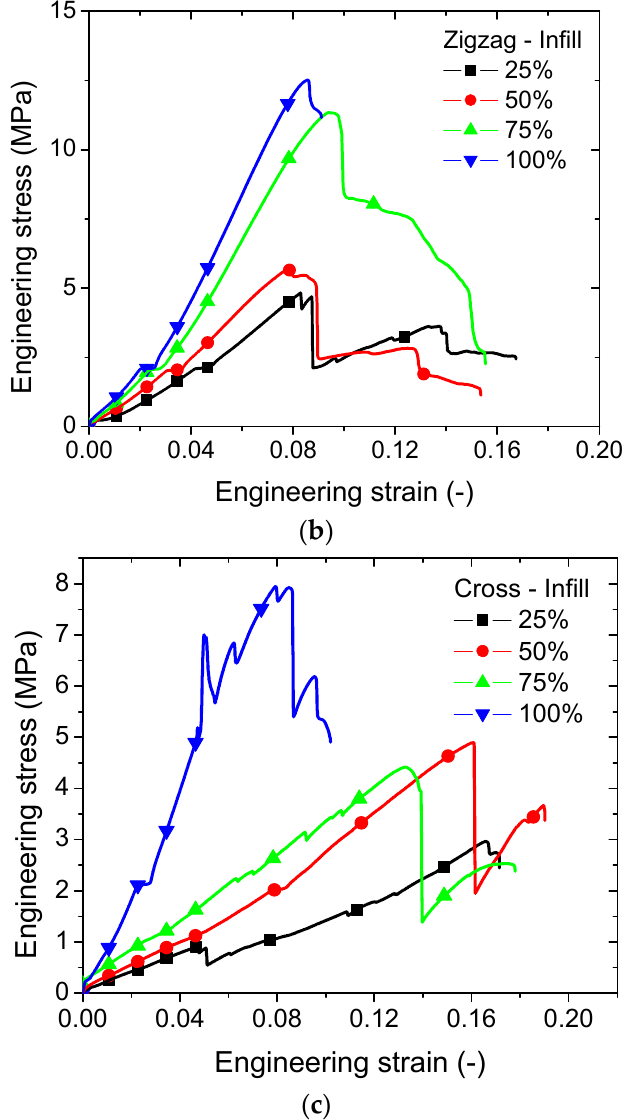
Figure 4. Tensile response as a function of infill and pattern type. ( a ) zigzag, ( b ) gyroid, ( c ) cross. The correlation between the engineering constants (Young’s modulus, tensile strength, elongation at break) and the infill ratio can be captured from Table 1. The increase of the infill ratio has a direct consequence on the improvement of stiffness and strength and the decrease of elongation at break of the printed PLA–carbon fibres. The ranking of all engineering constants with regards to the type of the pattern is also evidenced. This ranking from the best performing to the lowest is as follows: gyroid, zigzag, cross. According to the data reported in Table 1, the trend exhibited by each pattern is represented by the density–engineering constant curves shown in Figure